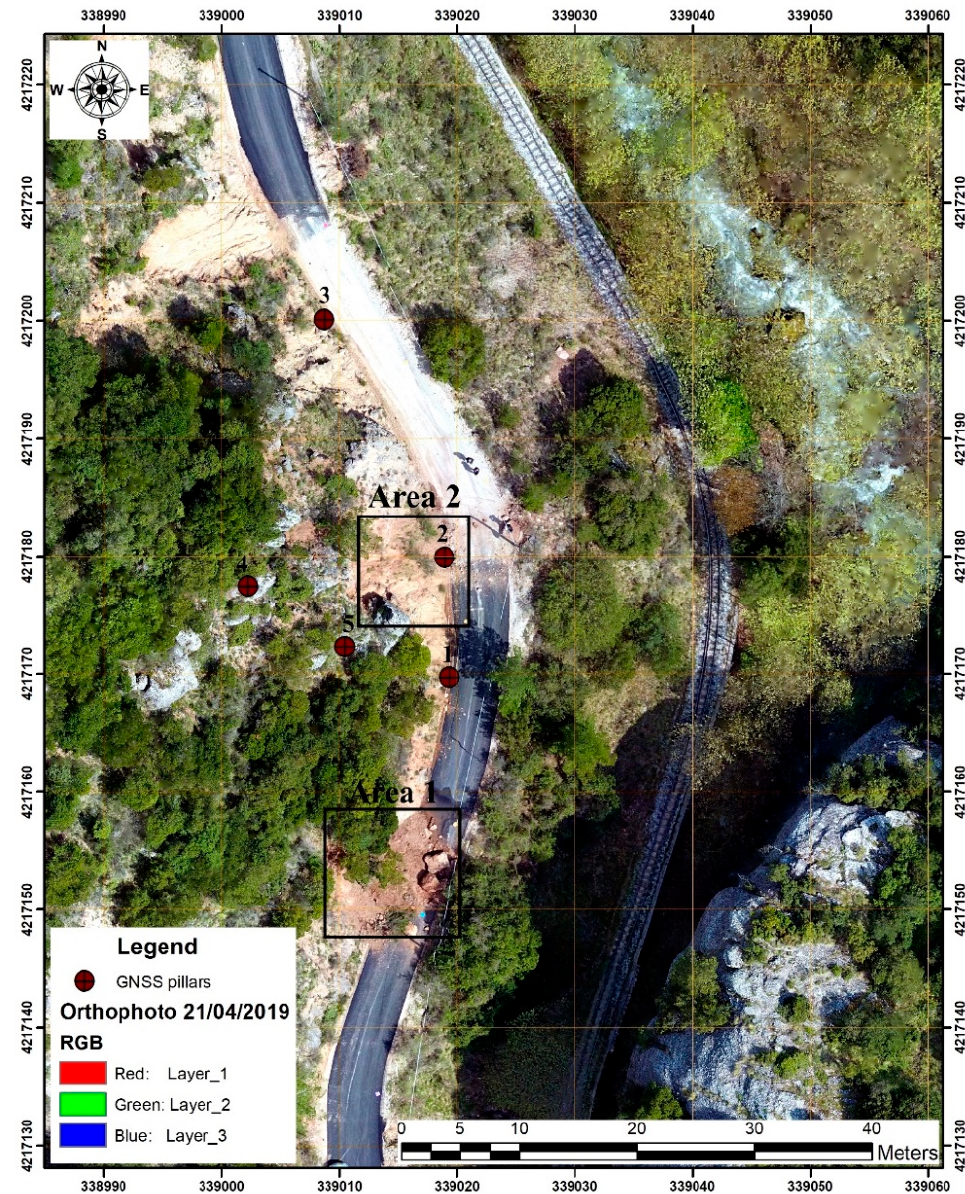
Figure 7. Distribution of the GNSS permanent pillars. The orthophoto presents the sliding area on 21 April 2019.